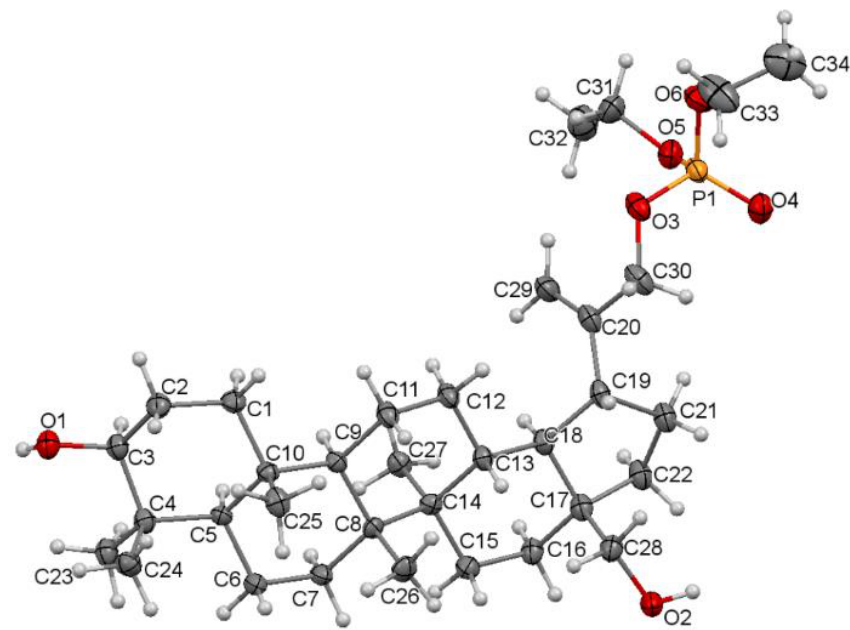
Figure 4. Molecular structure of the compound 5 showing the atom numbering scheme. Displacement ellipsoids are drawn at the 50% probability level.